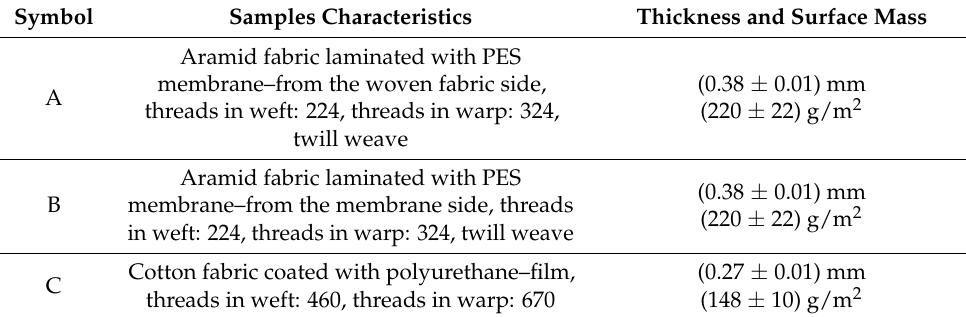
Table 1. Characteristics of textile materials used in studies.